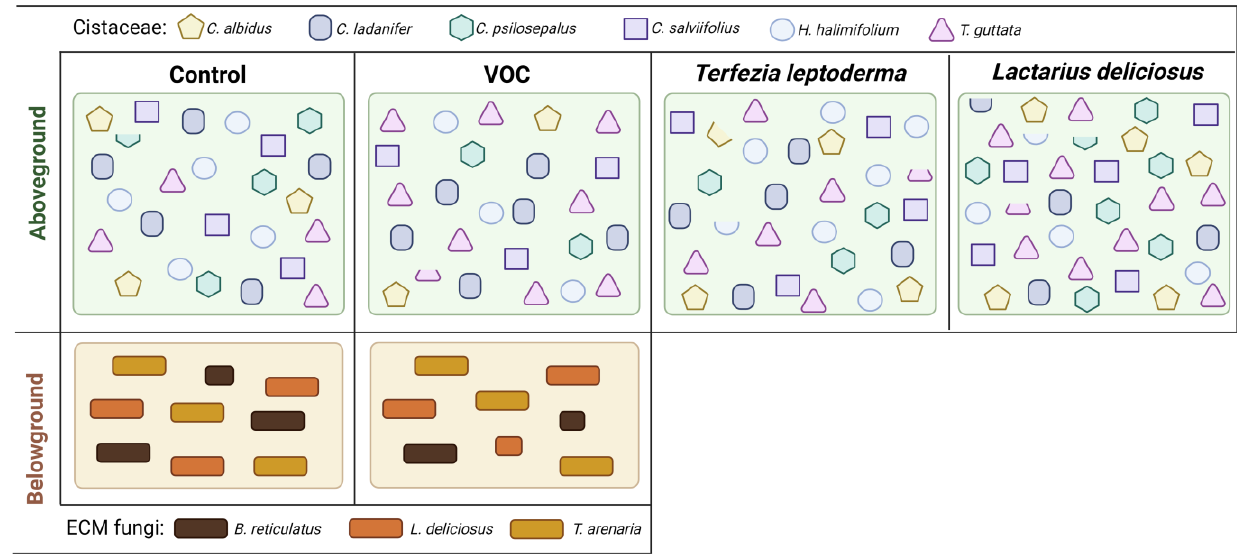
Figure 6. Illustration of the effects of 1-octen-3-ol, of external or biogenic origin, on below and aboveground communities, namely on the ECM mycelial growth and Cistaceae sp. germination.